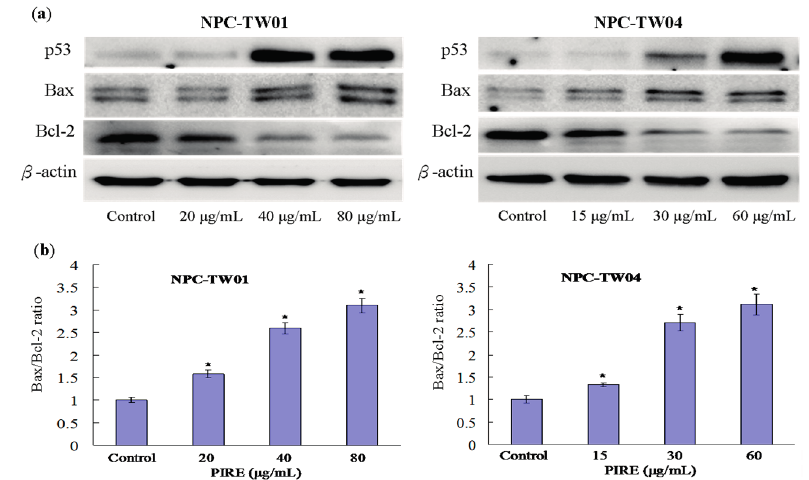
Figure 6. Effect of PIRE on the expression of p53, Bax and Bcl-2 proteins in NPC cells. ( a ) Cells were treated with varying concentrations of PIRE for 48 h and the expression of p53, Bax, Bcl-2 and β -actin was detected by Western blotting analysis; ( b ) The Bax/Bcl-2 ratios were increased by PIRE. The density of corresponding bands in ( a ) were quantitated and plotted as the ratio of Bax/Bcl-2. Results are the means ± SD from three experiments; * Means significantly different from control (0.1% DMSO) at the same dose at p <